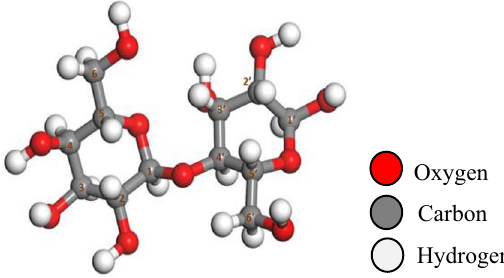
Figure 1. Optimized structure of the model compound